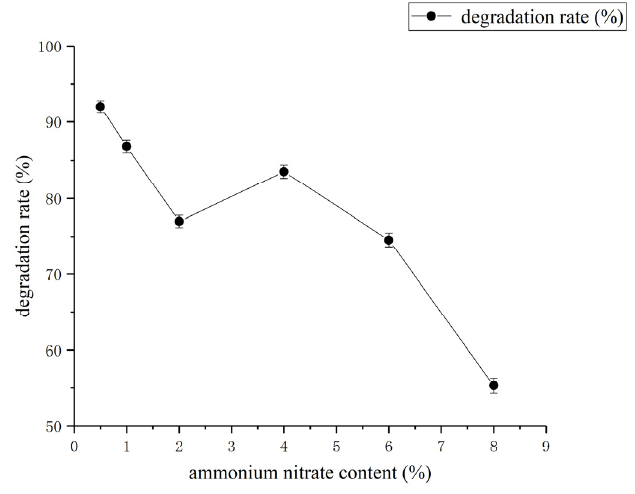
Figure 10. Effect of ammonium nitrate content on coumarin degradation rate. The data are presented as the mean ± SD of three independent experiments.